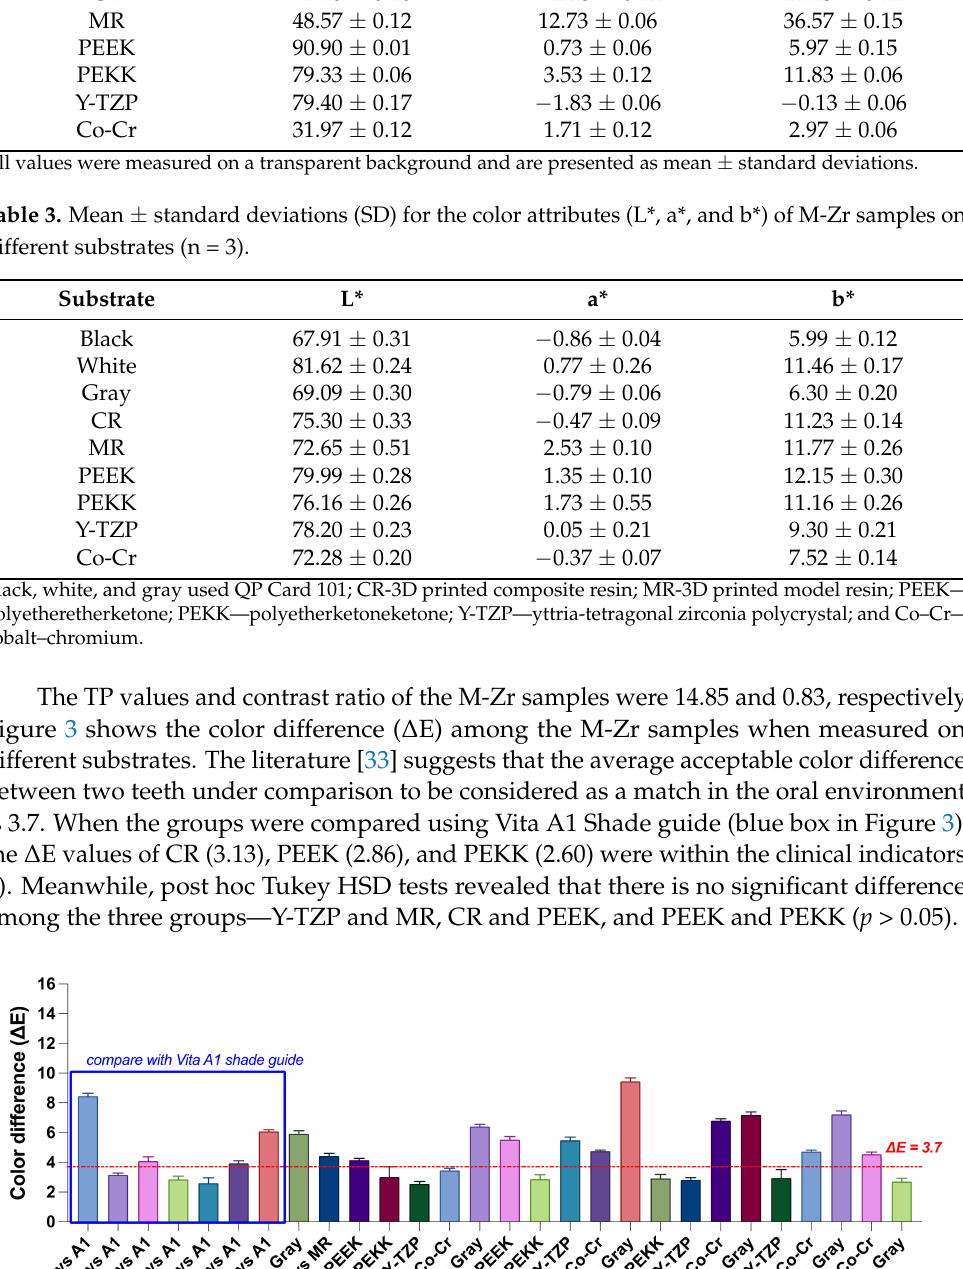
Table 2. The color attributes (L*, a*, and b*) of six different substrate materials (n = 10). Substrate Material